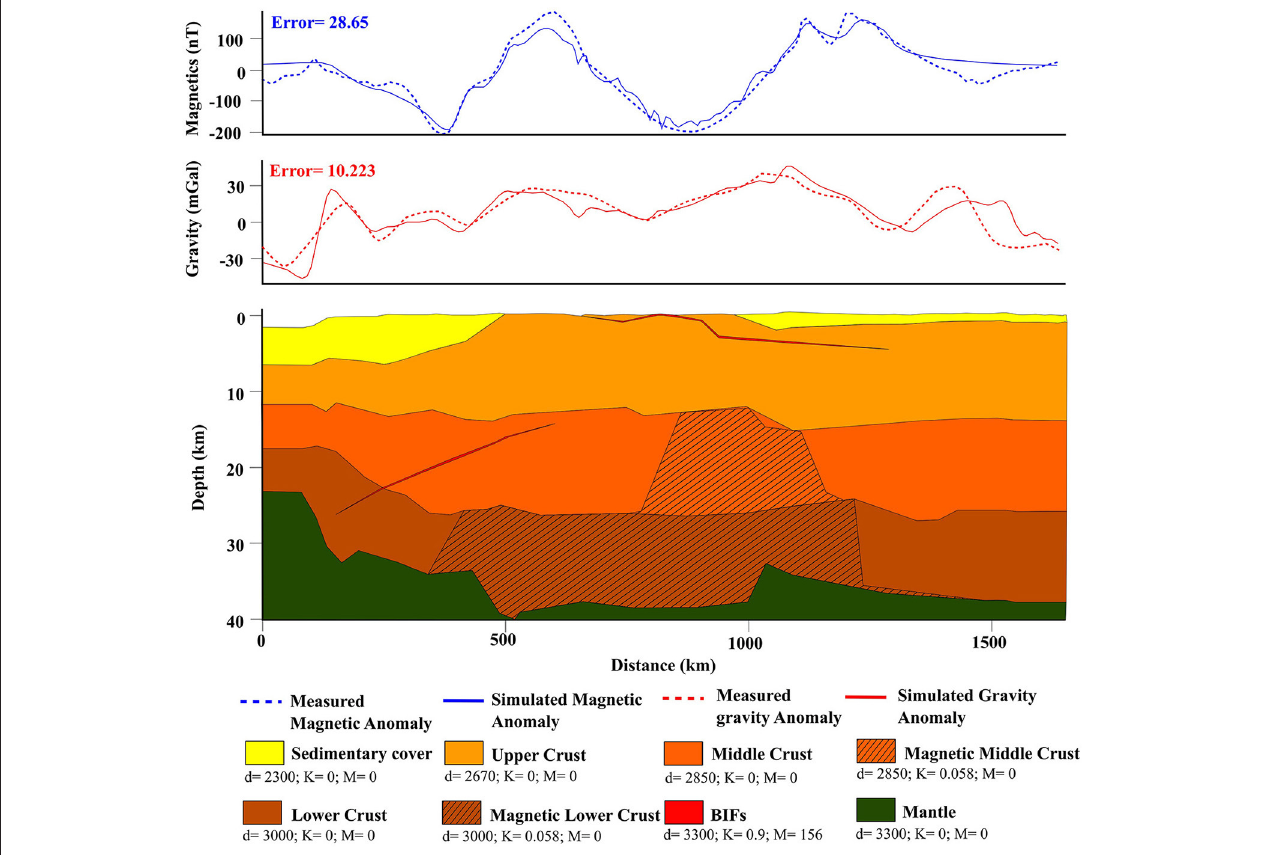
FIGURE 9 | Model of the crustal structure along profile C beneath the WAMA, with remanence, and considering deep BIFs. The parameters are identical to the ones in Figure 8 .